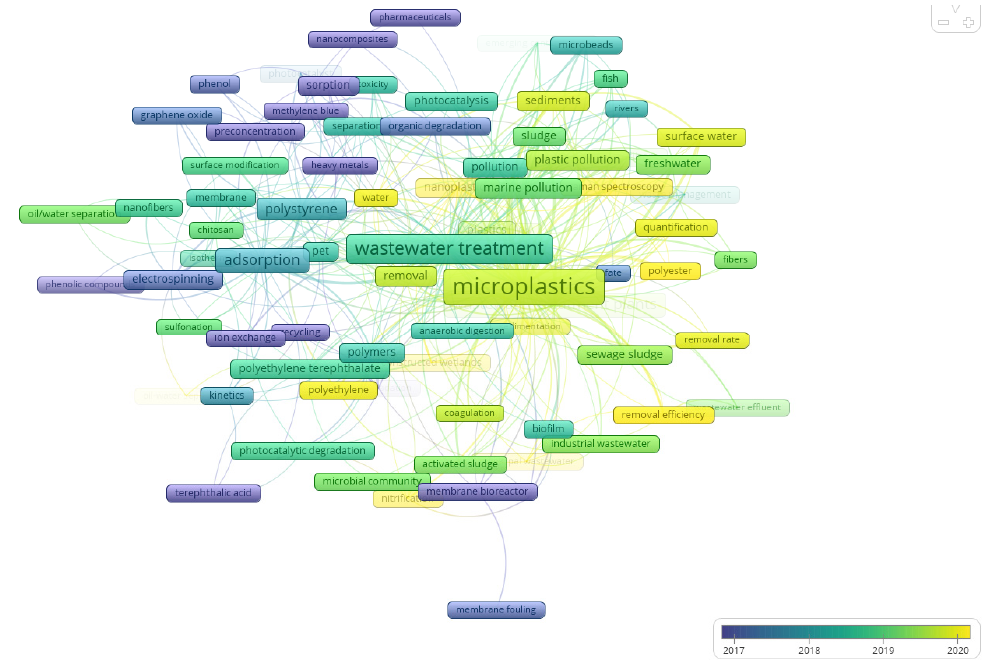
Figure 6. Co-occurrence map of the KWs with minimum occurrence of 5 in the articles derived from the query Q2. The color of item is associated to the average publication year (APY) of all the articles in which the related KW has been used. An interactive visualization of the map is available at https://bit.ly/2UAdKrt (in which the label_ frames can be selected). Accessed date: 30 May 2021.